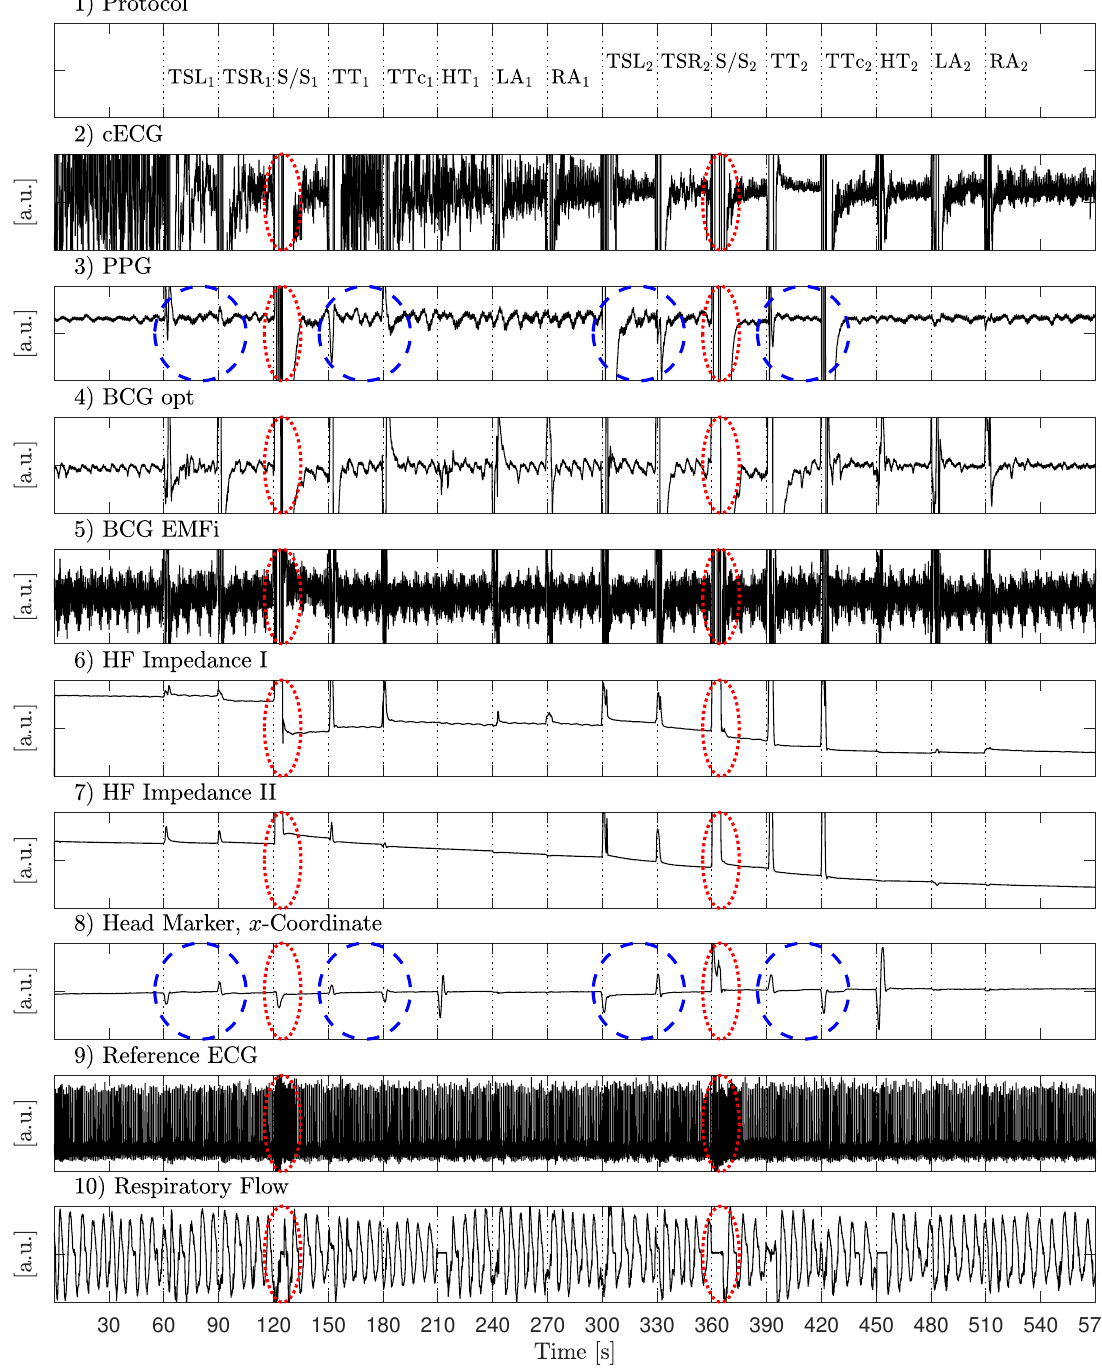
Figure 7. Measurement results for subject 2. Row 1 shows the protocol, rows 2 to 7 display the raw data of the unobtrusive sensors, rows 8 to 10 show the reference signals. Stand up/sit down is marked with red (pointed) ellipsoids in all channels. The blue (dashed) ellipsoids highlight the low and high amplitude torso shifts and torsions in the motion reference and the PPG channel. Note the different effects of left/right shift in the PPG channel. Modified from ([22], Figure 4) c (cid:13) 2015